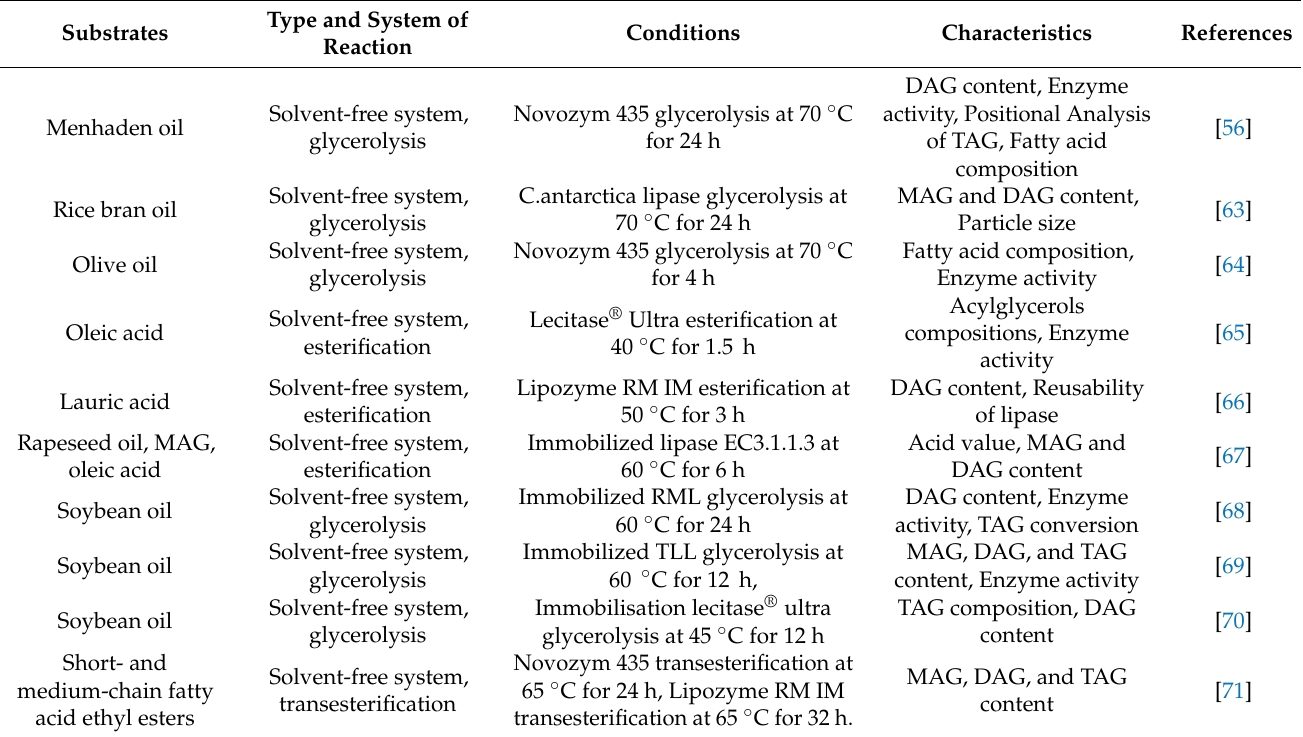
Table 4. Current enzymatic synthesis methods to produce